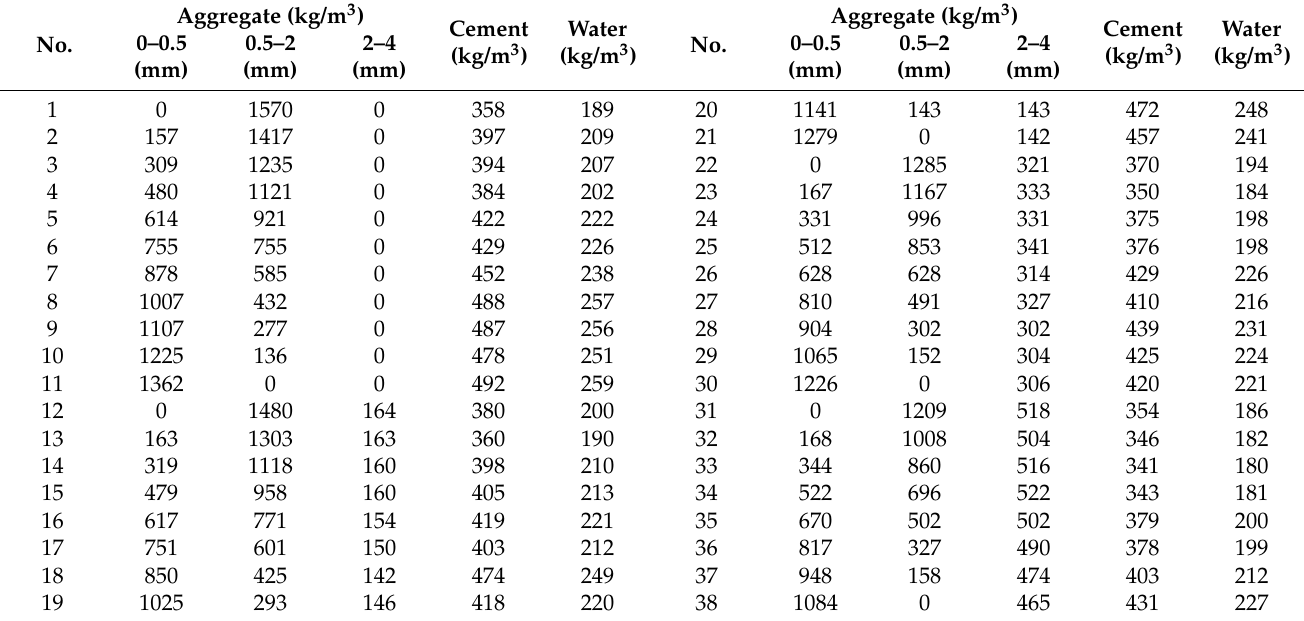
Table 1. Composition of concrete mixes used in the